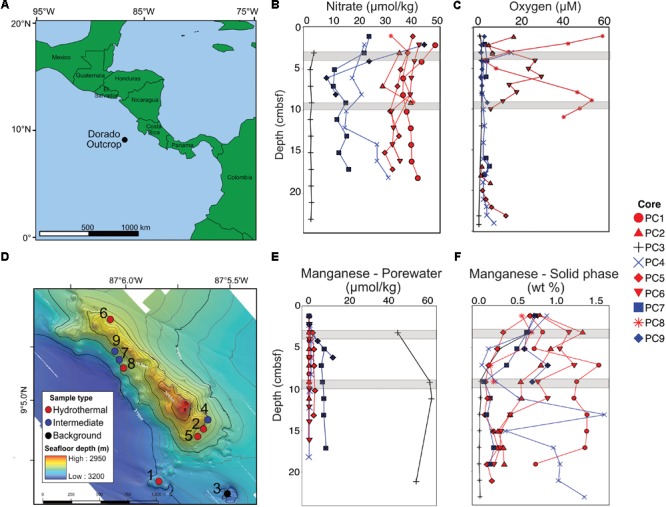
Overview of the Dorado Outcrop (A), locations of sediment core samples (D), and sediment geochemical profiles (B,C,E,F). (A) The Dorado Outcrop is located in the Eastern Tropical Pacific Ocean on a 23-million-year-old ridge flank of the East Pacific Rise. (B) Sediment profiles of pore fluid nitrate concentrations with depth (centimeters below seafloor, cmbsf). (C) Dissolved oxygen concentrations of sediment push cores from Wheat et al. (2017). (D) Bathymetric map of Dorado Outcrop, which is approximately 2 km long and 0.5 km wide, rising approximately 150 m above the surrounding thickly sedimented seafloor. Push core locations are marked by circles, with the corresponding core designation labeled next to the circles. Adapted from Wheat et al. (2017). (E) Dissolved and (F) solid phase manganese profiles from sediment push cores. In (B–F), sediment cores were classified based on nitrate profiles, which have been shown to demonstrate advective fluid flow from the ocean basement into the thin sediments on Dorado Outcrop (Wheat and Fisher, 2008). Symbol color represents hydrothermal (red), intermediate (blue), and background sediment (black) groups. Gray areas represent where samples were collected for 16S rRNA gene analysis.